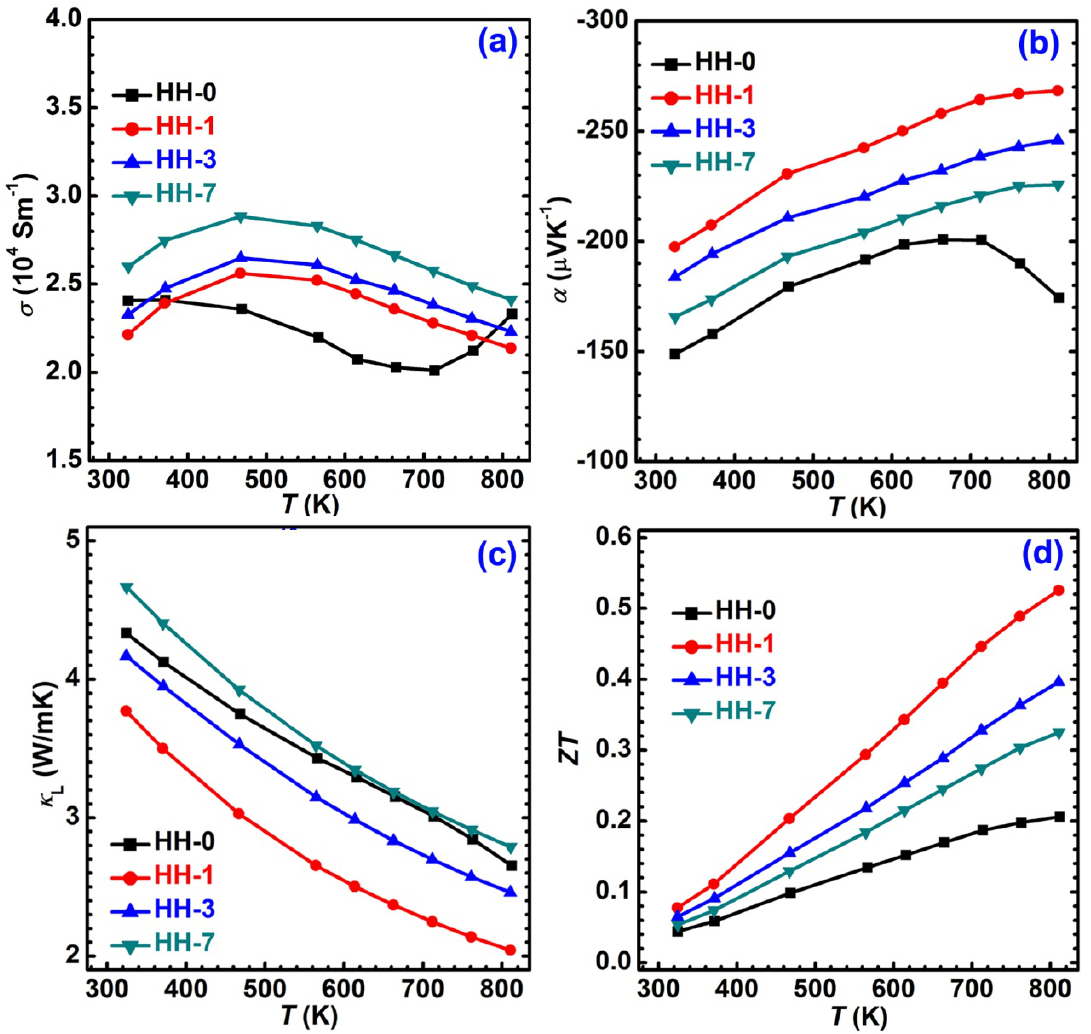
Figure 11. TE transport properties of the (Ti,Zr,Hf)(Co,Ni)Sb-x at.% InSb nanocomposites (“HH” represents the formula (Ti,Zr,Hf)(Co,Ni)Sb, and x = 0, 1, 3, and 7.): ( a ) the Seebeck coefficient; ( b ) electrical resistivity; ( c ) thermal conductivity; and ( d ) dimensionless figure of merit ZT values. Reproduced with permission from Reference [79]. Copyright 2010,